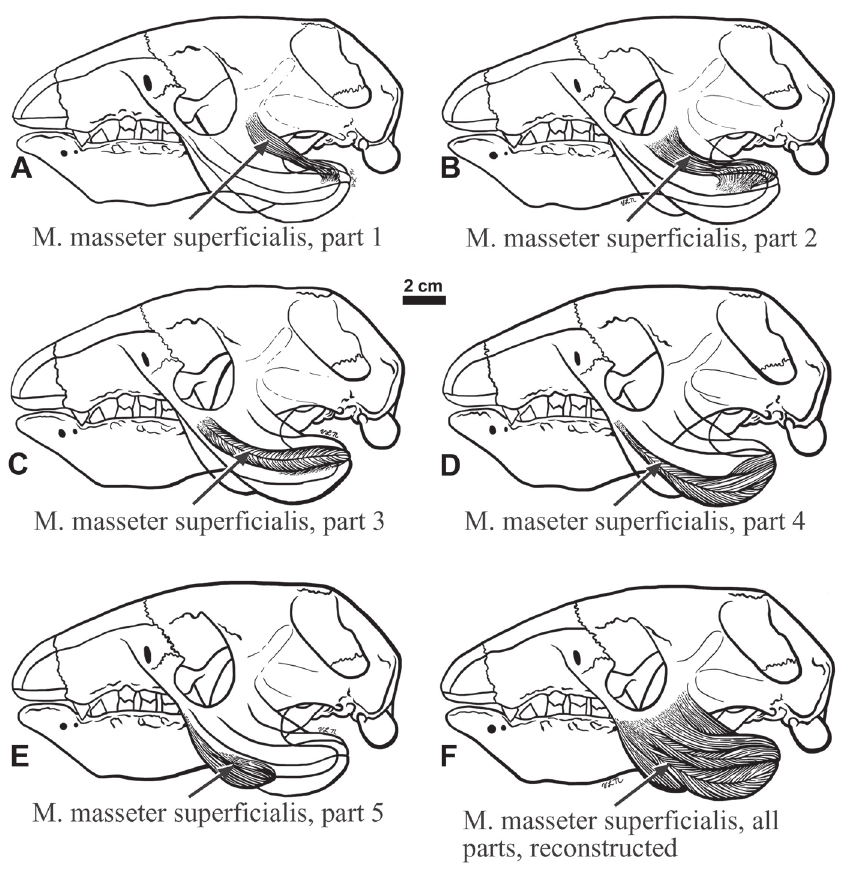
Figure 9. The five distinct parts of the superficial masseter muscle of Hapalops are shown in lateral view ( A – E ), with a composite muscle restored in F . The muscle has been reconstructed based on the scars of origin and insertion, and in relation to those dissected in the tree sloths, Bradypus and Choloepus